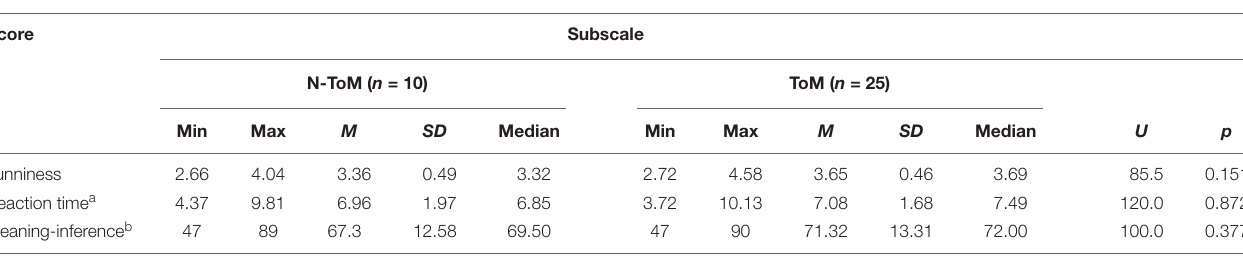
TABLE 3 | Descriptives and comparison of ToM-HCAT scores and reaction times for cartoons in subscales.